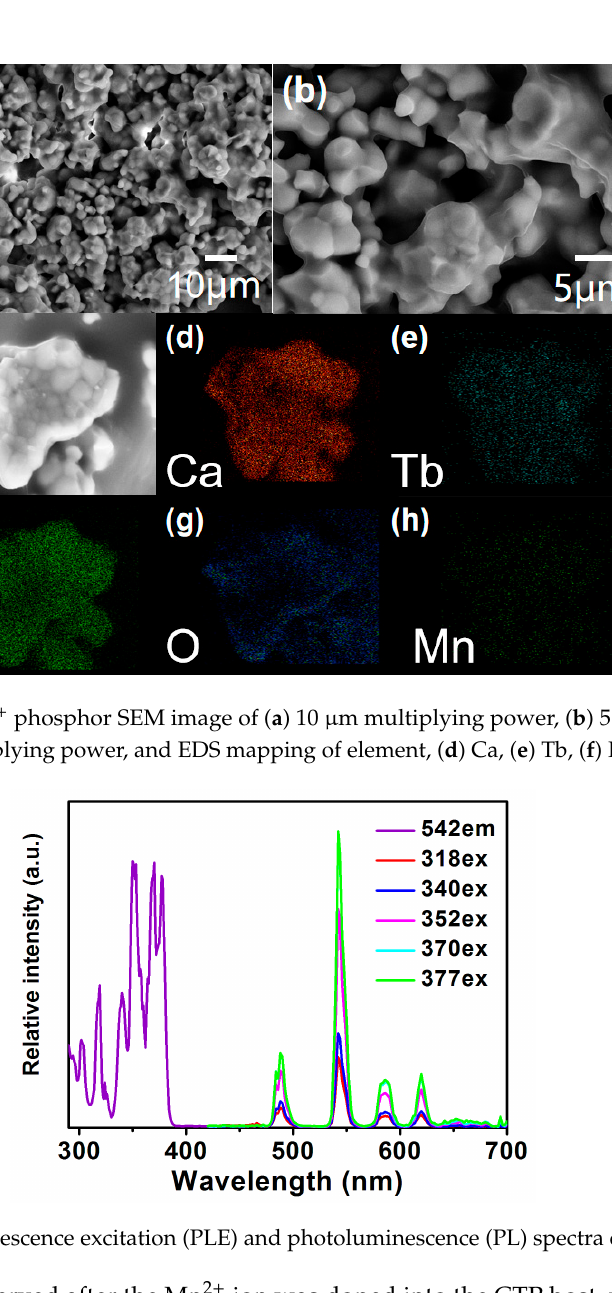
Figure 3. Photoluminescence excitation (PLE) and photoluminescence (PL) spectra of the CTP host.